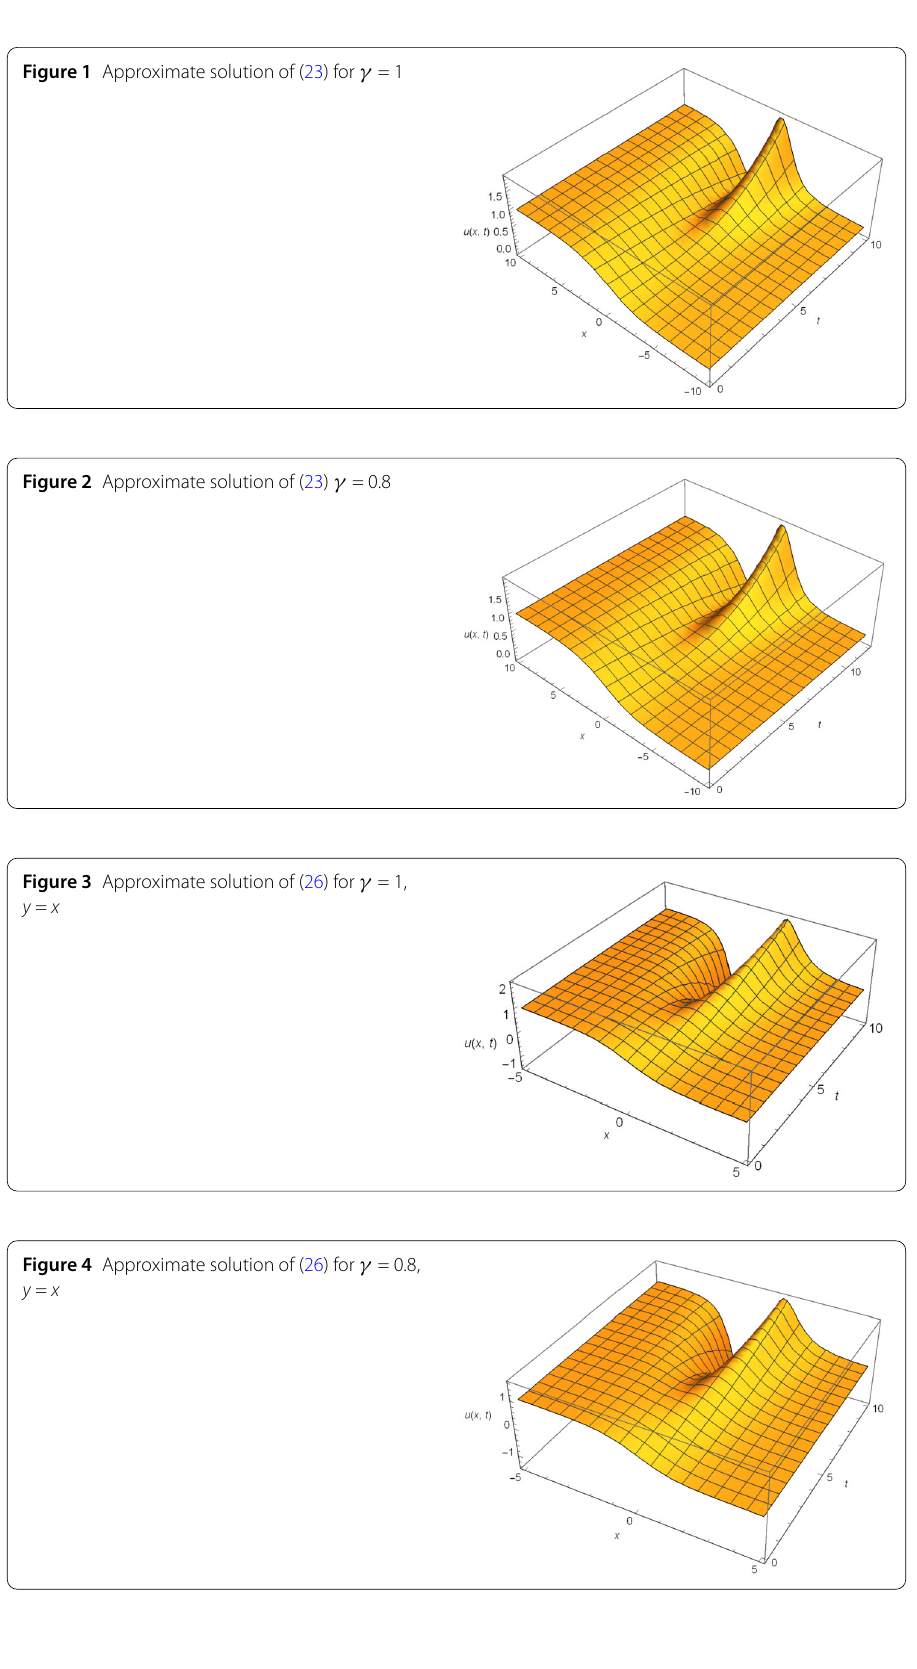
Figure 1 Approximate solution of (23) for γ = 1